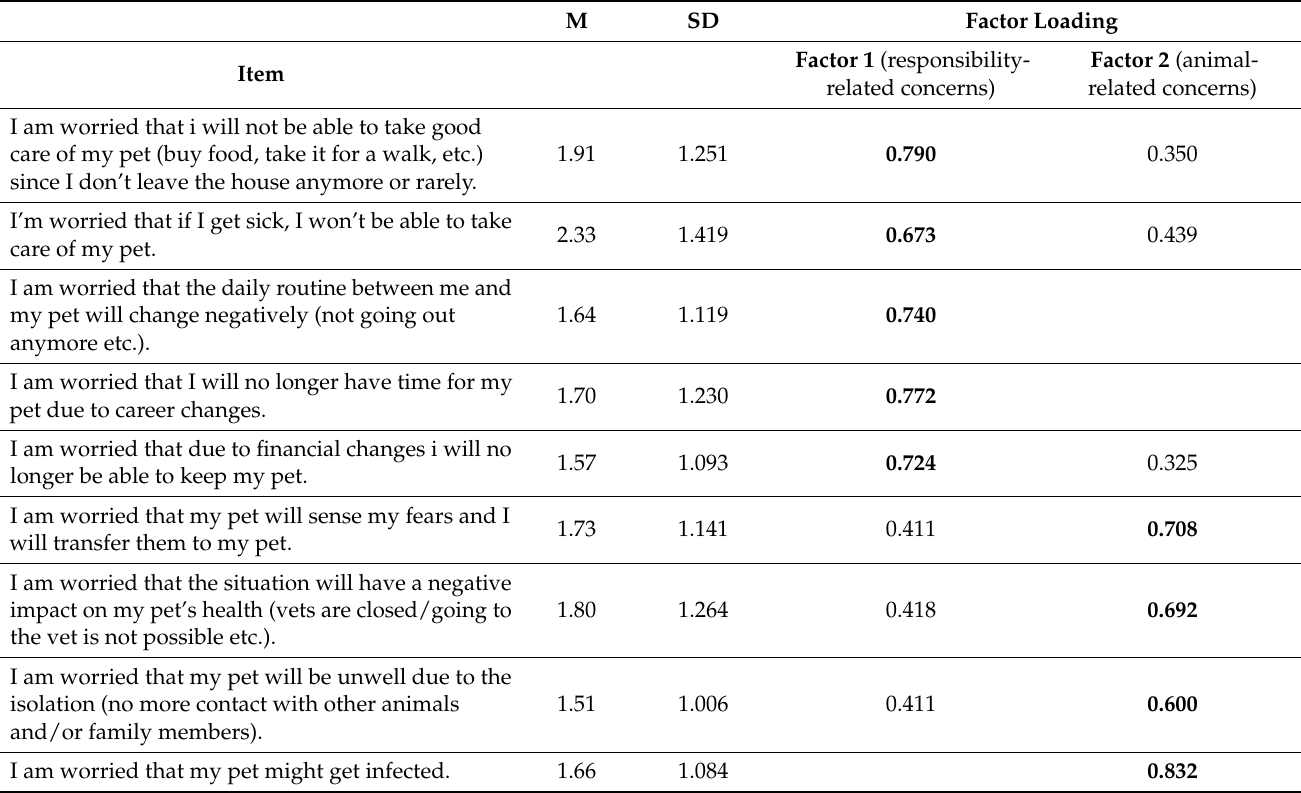
Table 1. Factor analysis of pet-related concerns.